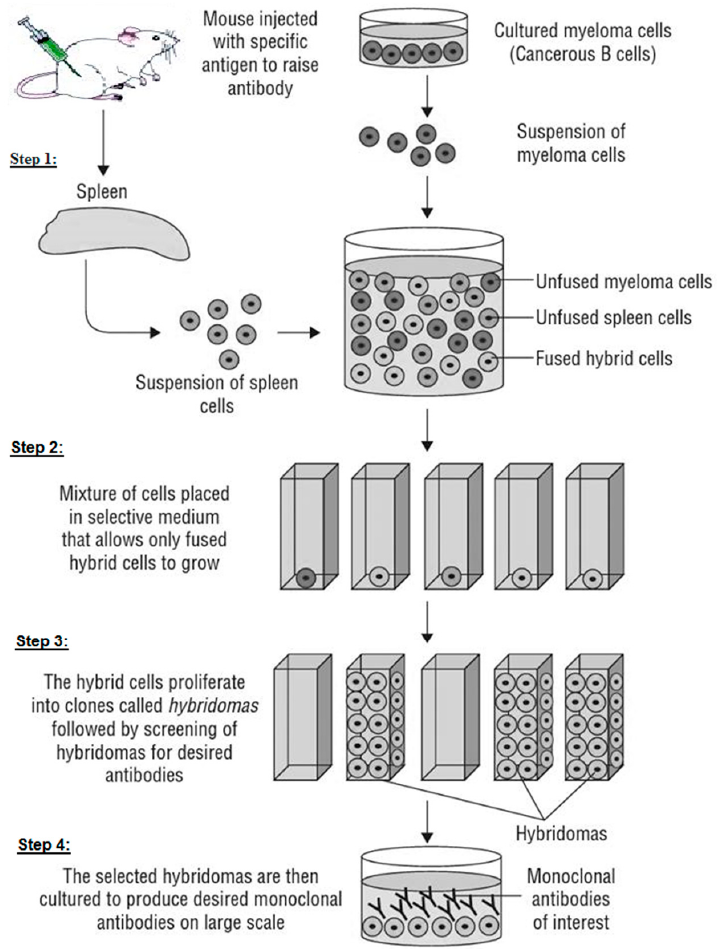
Scheme 2. A schematic diagram showing the production of monoclonal antibodies